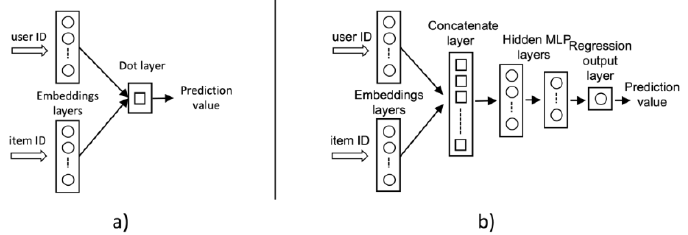
Figure 1. Deep matrix factorization ( a ) vs. neural collaborative filtering ( b ) recommender system models.